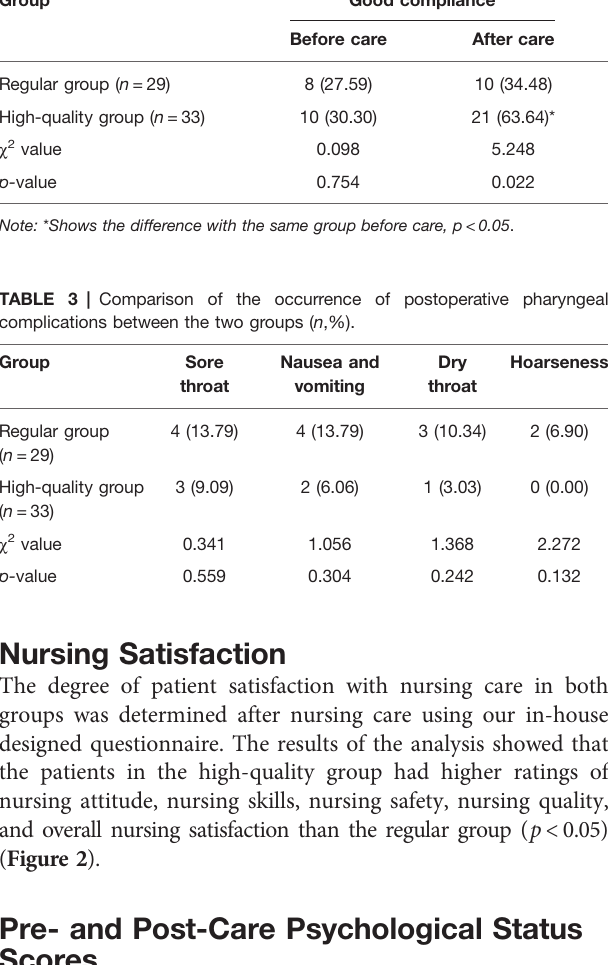
TABLE 2 | Comparison of compliance before and after care between the two groups ( n , %). Group Good compliance Partially compliant Before care After care Before care After care Before care After care